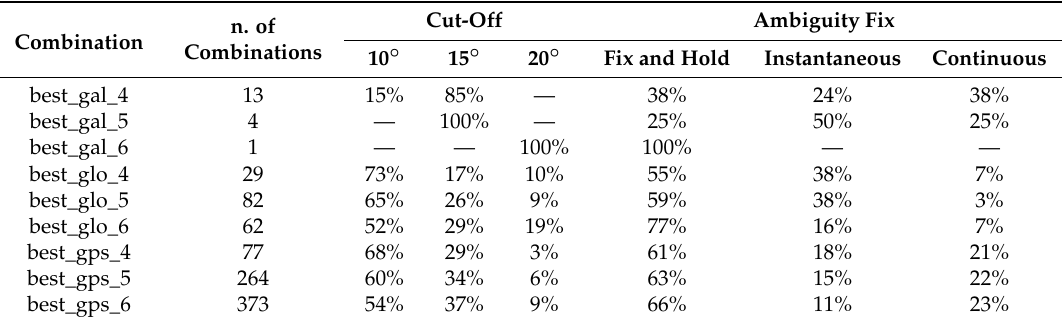
Summary of the selected RKTLIB trajectories for the subsequent